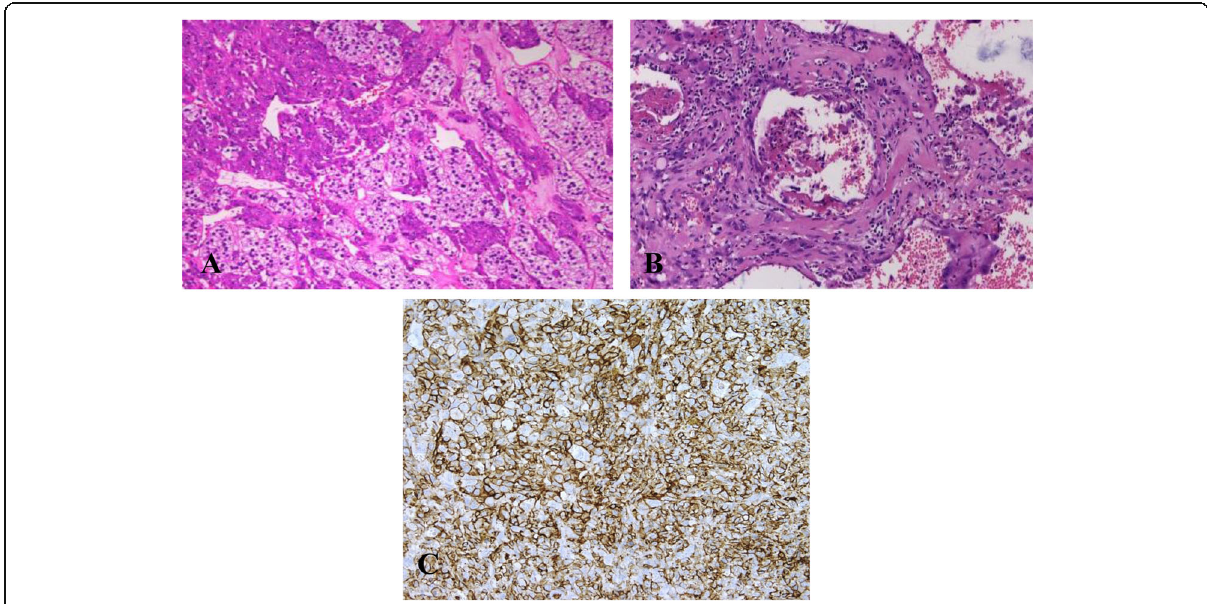
Fig. 2 a Primary adrenal angiosarcoma showing irregular anastomosing vascular channels lined by a typical pleomorphic cells infiltrating the adrenal cortical cells (Hematoxylin and eosin, × 100). b Infiltration by atypical anastomosing vascular spaces lined by endothelial cells exhibiting large vesicular nuclei and abundant esoinophilic cytoplasm were seen (Hematoxylin and eosin, × 200). c Immunohistochemical staininsg showed